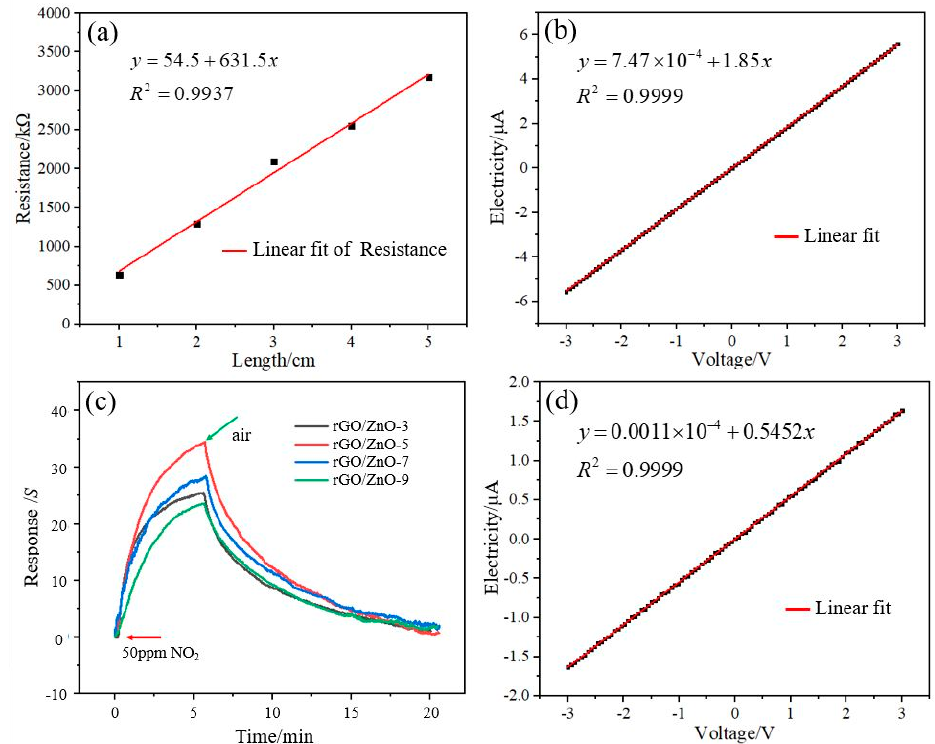
Figure 2. ( a ) Length and resistance relationship curve of the rGO nylon fiber; ( b ) I–V characteristic curve of the rGO nylon fiber sensor; ( c ) NO 2 gas sensing performance curve of nylon fiber sensors with different ZnO QDs contents; and ( d ) I–V characteristic curve of the rGO/ZnO-5 nylon fiber sensor.